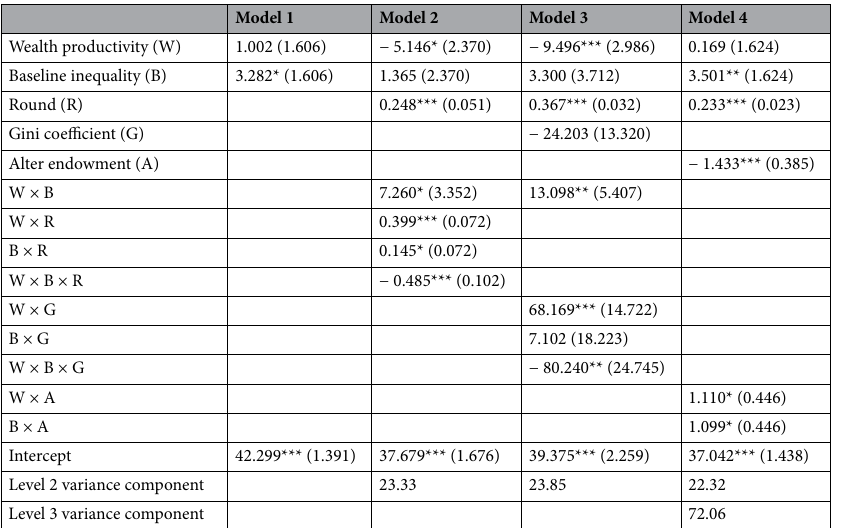
Figure 2. Average ( A ) cooperation and ( B ) inequality (Gini coefficient) by experimental condition through time. No Productivity, Equality indicates no wealth productivity and baseline endowment equality. Productivity, Inequality indicates wealth productivity and baseline endowment inequality.